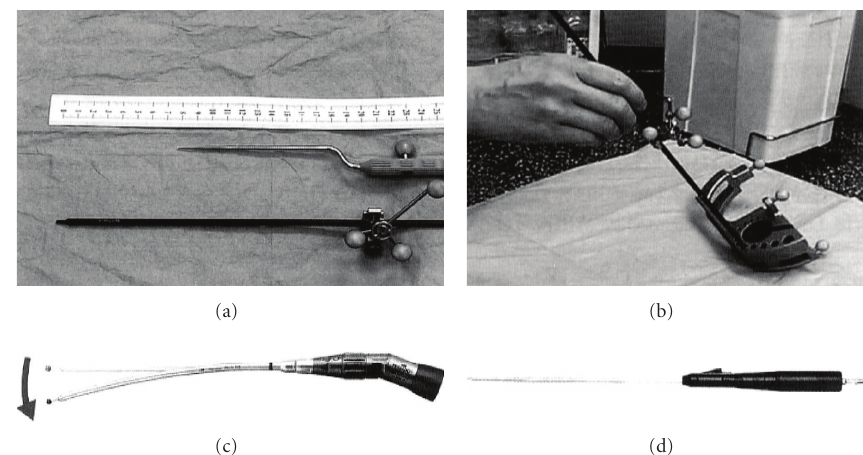
Figure 1: An original long navigation pointer (a) registered by the Universal Instrument Integration system ((b): VectorVision: BrainLAB Co., Ltd.). Long and slim instruments we used for this operation, highspeed drill ((c): Primado: NakanishiCo., Ltd.) and ultrasonic aspirator ((d): SONOPET: M&M Co., Ltd.).